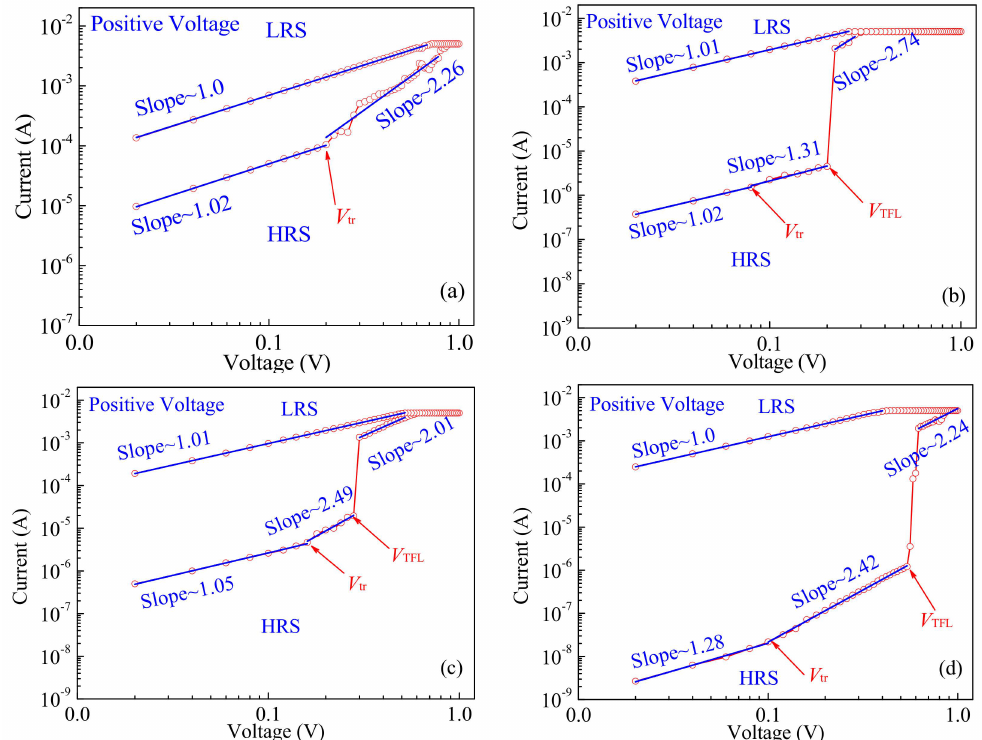
Figure 7. Logarithmic plot of the I - V curves for the HRS and LRS under the positive bias region: ( a ) The device-A; ( b ) The device-B; ( c ) The device-C; ( d ) The